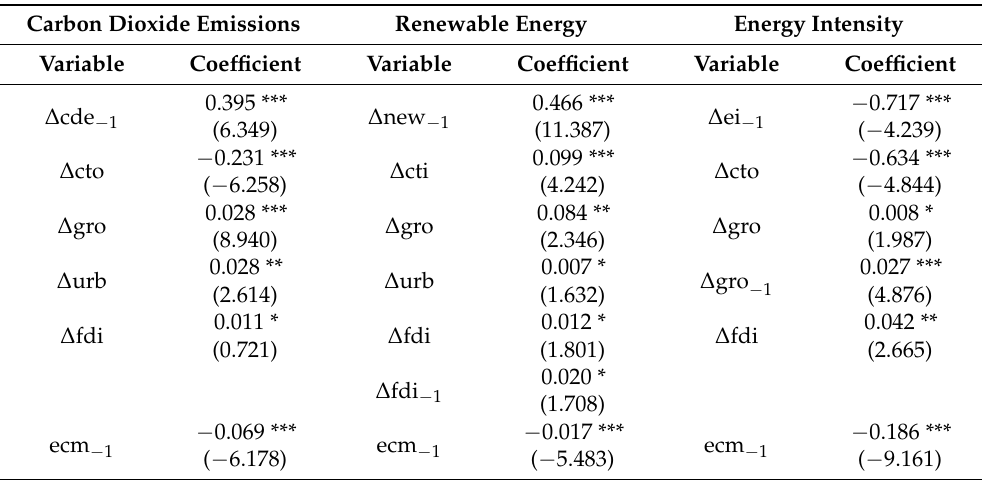
Table 4. Results of the short-run